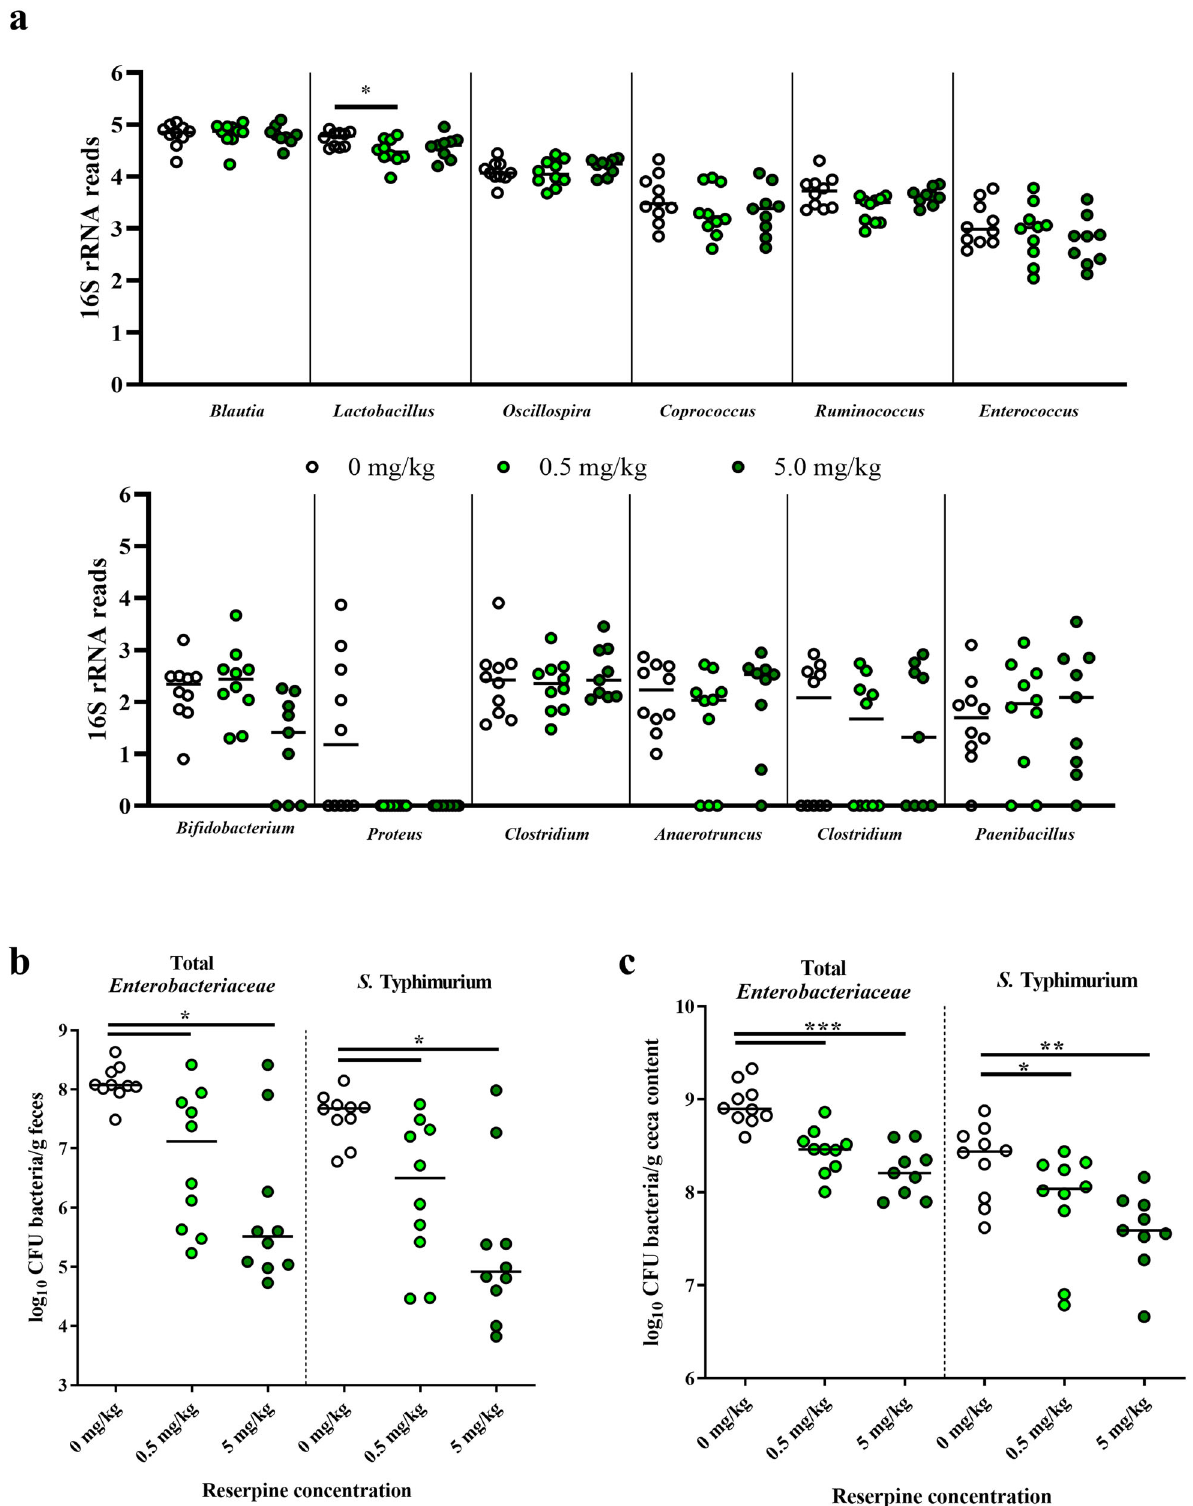
Fig. 2 Effect of oral reserpine treatment on commensal and pathogenic bacteria. Oral reserpine treatment did not dramatically affect the composition of the commensal ceca microbiome at the genera level ( a ). However, post- Salmonella Typhimurium UK-1 challenge, reserpine treatment reduced total Enterobacteriaceae and S . Typhimurium UK-1 ( b , c ). Signi fi cant differences indicated by asterisks: * P < 0.05; ** P < 0.01; *** P < 0.001. Error bars indicate the standard deviation above and below the